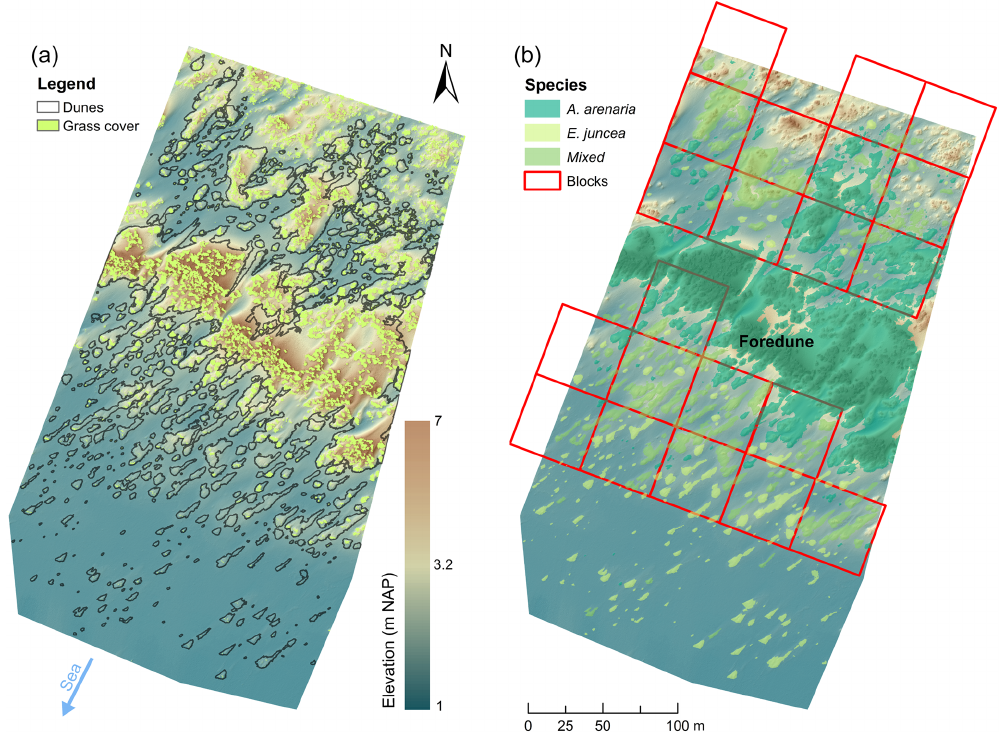
Figure 3. Overview of the monitoring area. (a) The elevation is shown with the digital terrain model (mNAP), the green pixel indicates grass cover and the polygons indicate the nebkha dunes. (b) The colour indicates the species present on the nebkha dune and the squares the blocks. The foredune in the middle of the monitoring area is excluded from the statistical analysis. Some dunes were cut off by the edge of the DTM – we discarded these